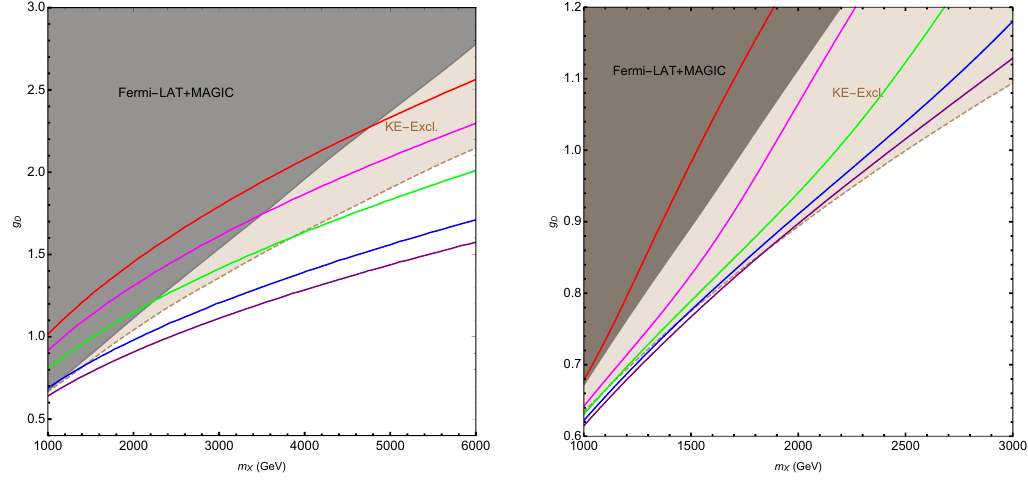
Figure 6 . The dark gray region is excluded by Fermi-LAT data [9] at 95% CL, while the brown region is excluded by out of kinetic equilibrium of DM. Solid lines corre- spond to the parameters which can reproduce Ω X h 2 = 0 . 12 [51]. Left panel: colored lines indicate ξ eff = 10 − 4 (red), 5 × 10 − 4 (magenta), 10 − 3 (green), 2 × 10 − 3 (blue), 4 × 10 − 3 (purple) by fixing r 1 / 2 = 1 . 3 , t (cid:15) = 10 − 11 . Right panel: colored lines indicate XZ 0 m X / Λ 0 = 0 . 020 (red), 0 . 025 (magenta), 0 . 030 (green), 0 . 035 (blue), 0 . 040 (purple) by fixing r 1 / 2 = 1 . 3 , t (cid:15) = 10 − 11 , ξ X = ξ Z 0 = 10 − 5 XZ 0